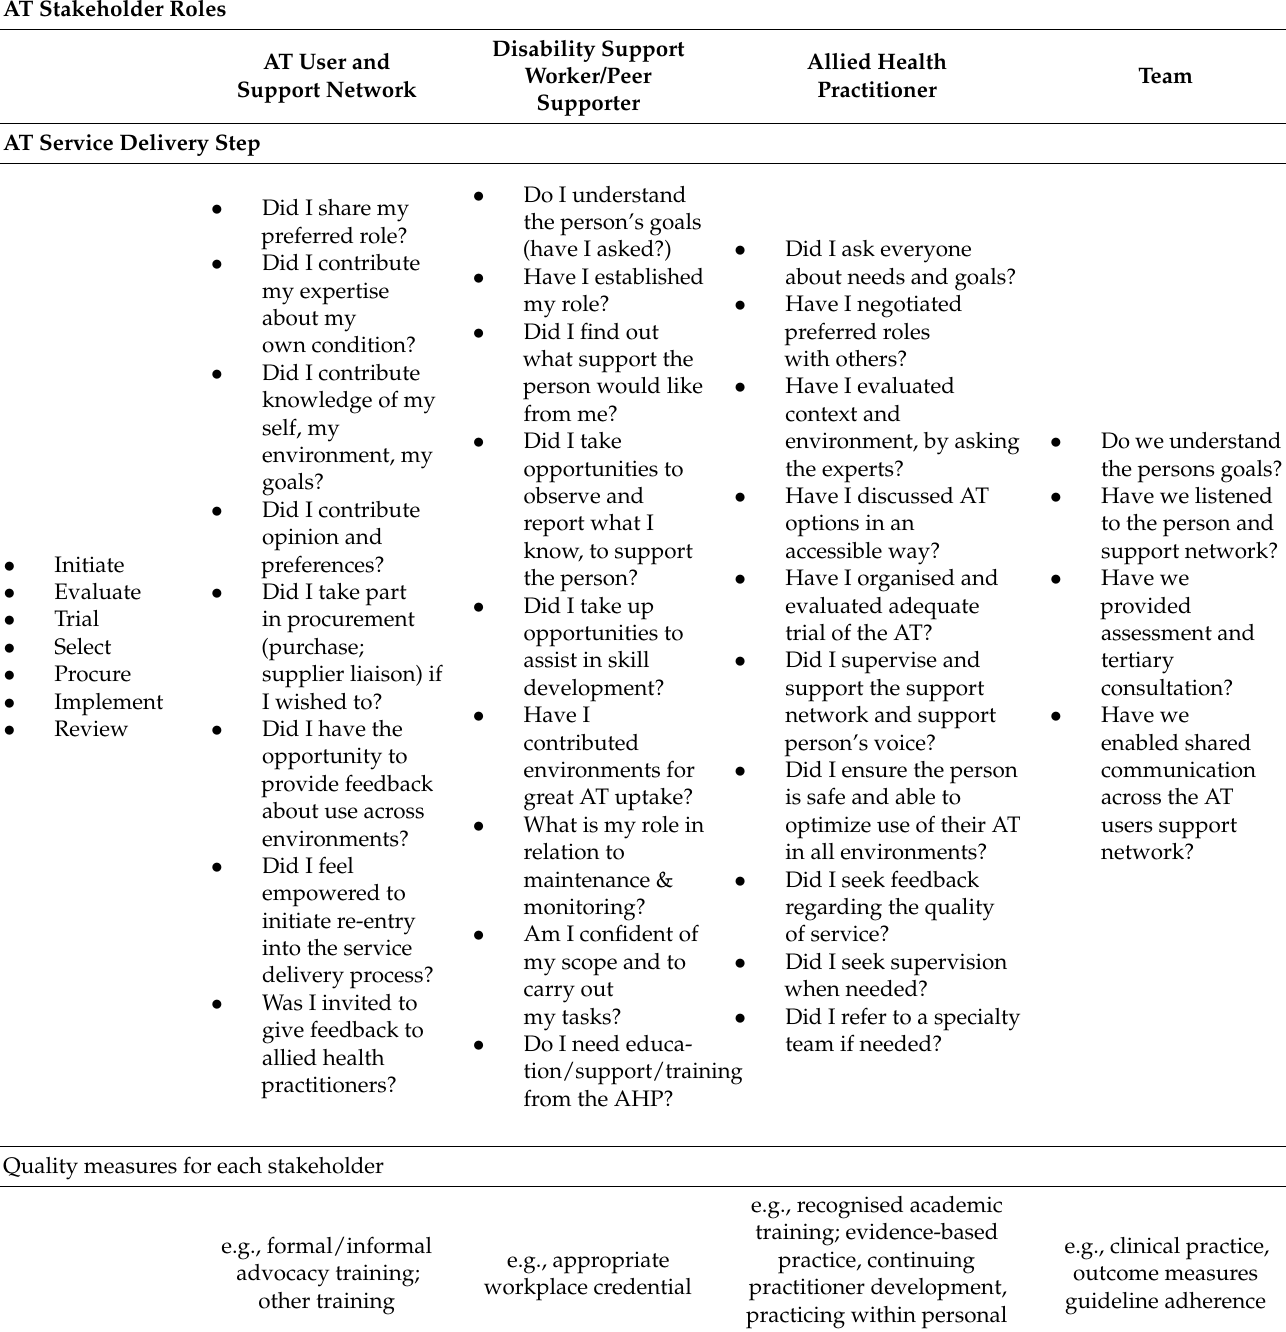
Table 2. AT collaboration